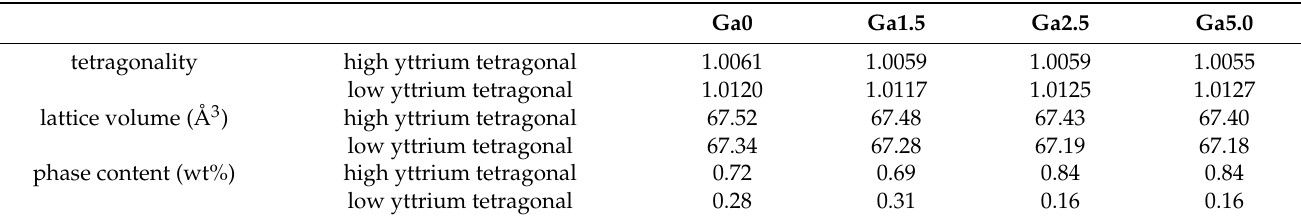
Figure 7. X-ray diffraction patterns of each sample. Diamonds indicate the diffraction peaks of the high and/or low yttrium tetragonal phase of yttria stabilized zirconia. The inset shows an enlarged view from 59.0° to 60.4°. Black line; Ga 0, red line; Ga1.5, blue line; Ga2.5, green line; Ga5.0. The h-t and l-t used to indicate the Miller index in the inset indicate high yttrium tetragonal and low yttrium tetragonal, respectively. Table 6. Tetragonality, lattice volume and phase contents of each sample.